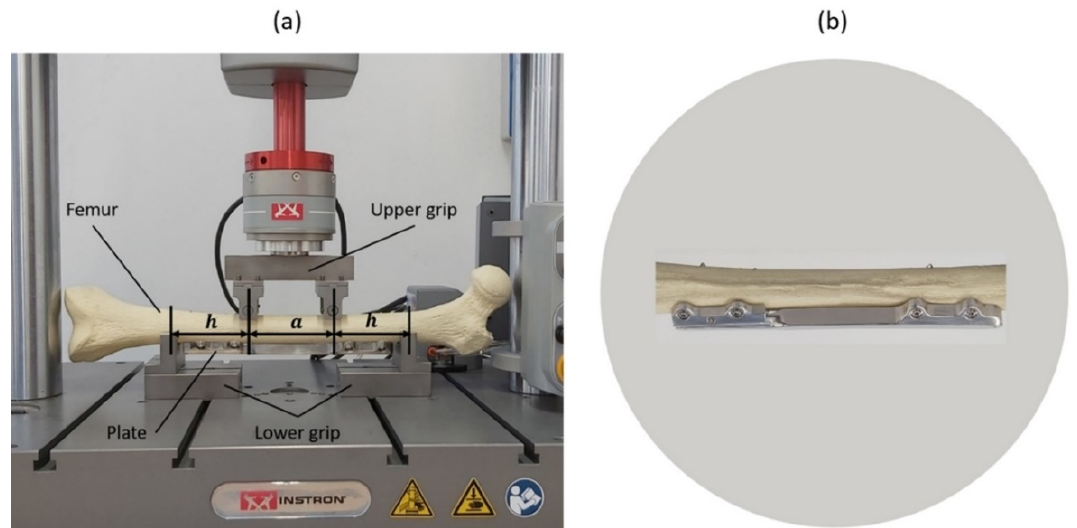
Figure 6. Four point bending test with Instron Electropulse E3000: ( a ) loading set up; ( b ) plate detail.